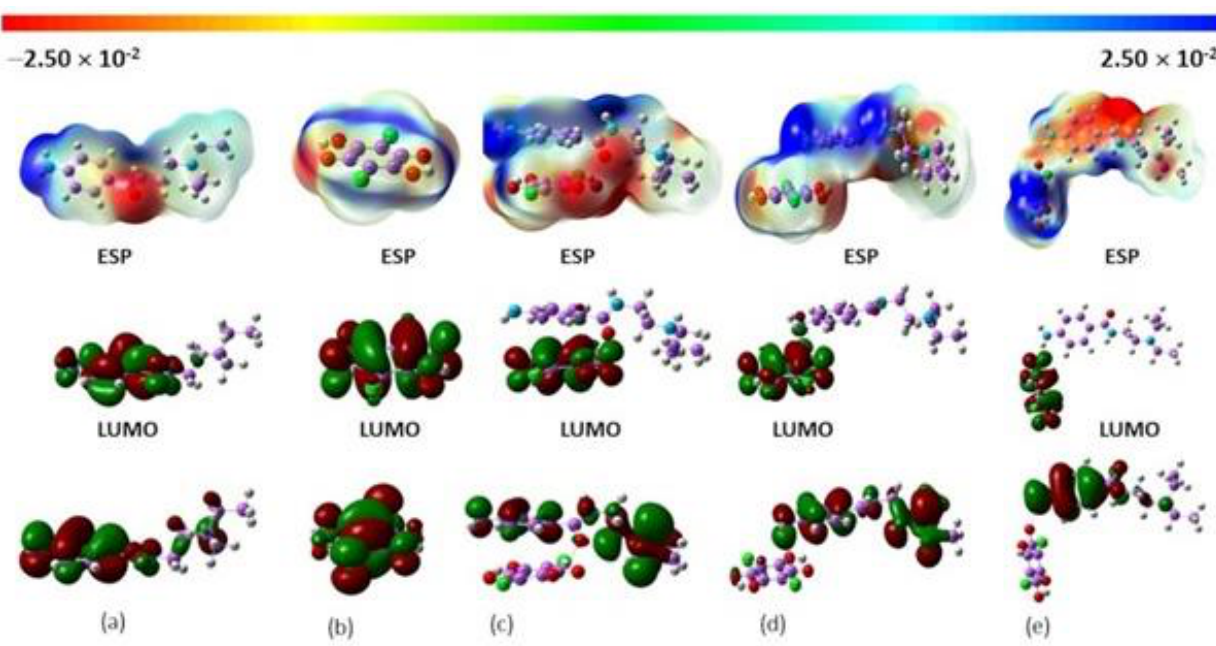
Figure 12. Molecular electrostatic potential (MEP) maps of HOMO and LUMO structures of PA, ChA, and their 1:1 complex: ( a ) PA; ( b ) ChA; ( c ) face-to-face I fashion complex of PA with ChA; ( d ) face-to-face II fashion complex of PA complex with ChA; and ( e ) edge-to-edge fashion complex of PA with ChA at the ω B97XD/6-311++G(2d,p) level of theory in acetonitrile solvent system.